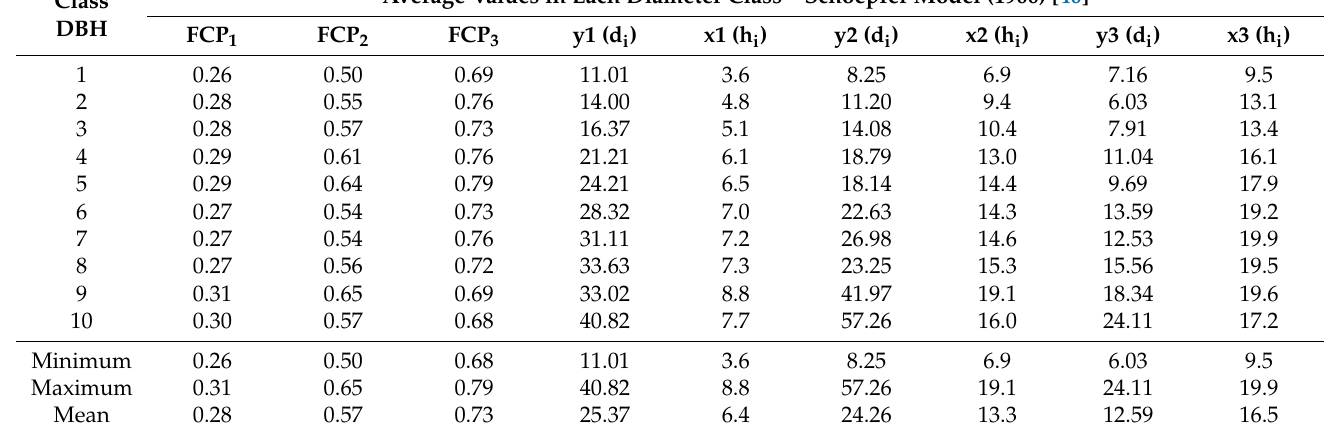
Table 5. Minimum, average and maximum DBH values and the total height of the form change points of the stem in each diameter class using the model of Schöepfer [40] for Tectona grandis L.f., central-west region, Brazil.